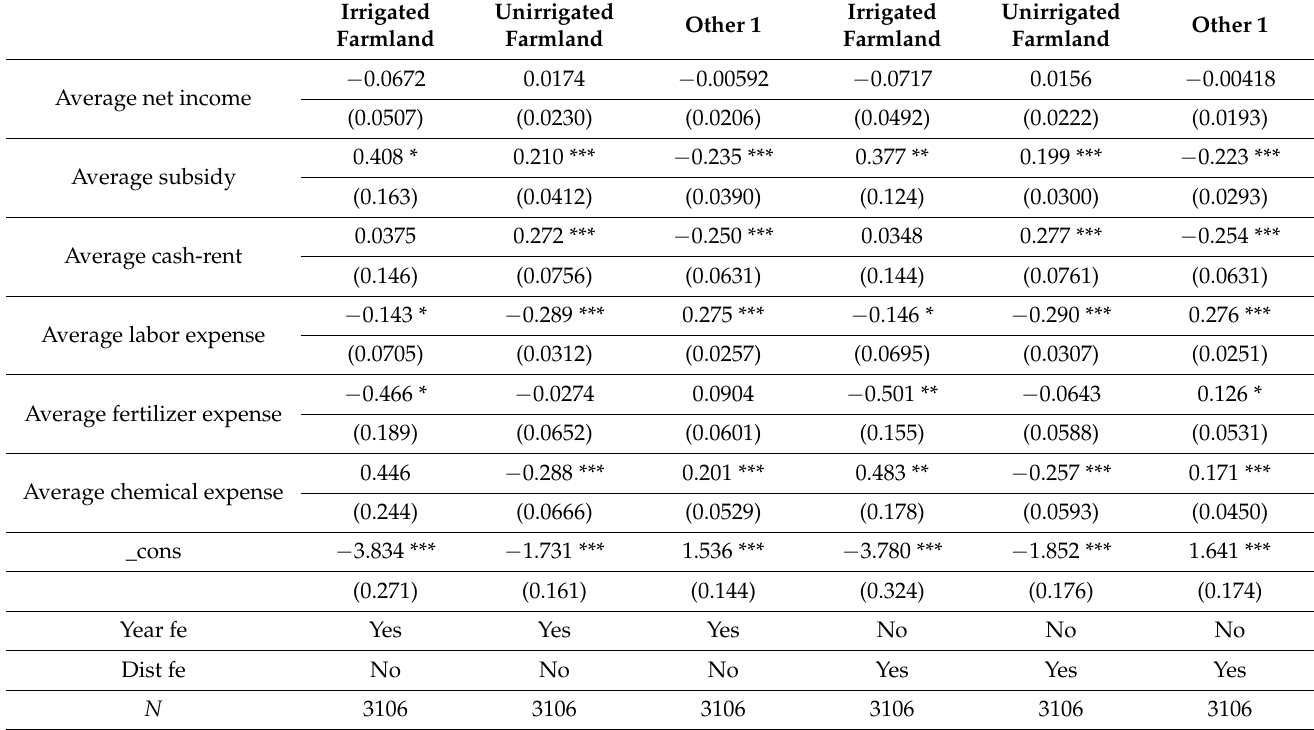
Table 4. Estimated Coefficients on Land-Use of Irrigated Farmland and Unirrigated Farmland in Multinomial-Fractional-Logit Model with Lagged Variables. Irrigated Unirrigated Irrigated Other 1 Farmland Farmland Farmland